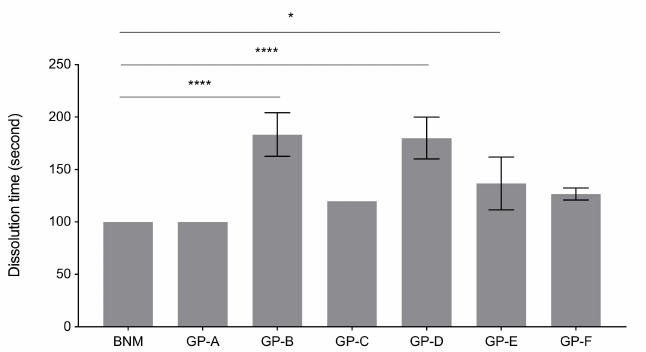
Figure 2. Comparison of dissolution time under laboratory conditions between BNM and six GPs (N = 3 batches. p < 0.05 was considered statistically significant. **** p < 0.0001, * p < 0.05).